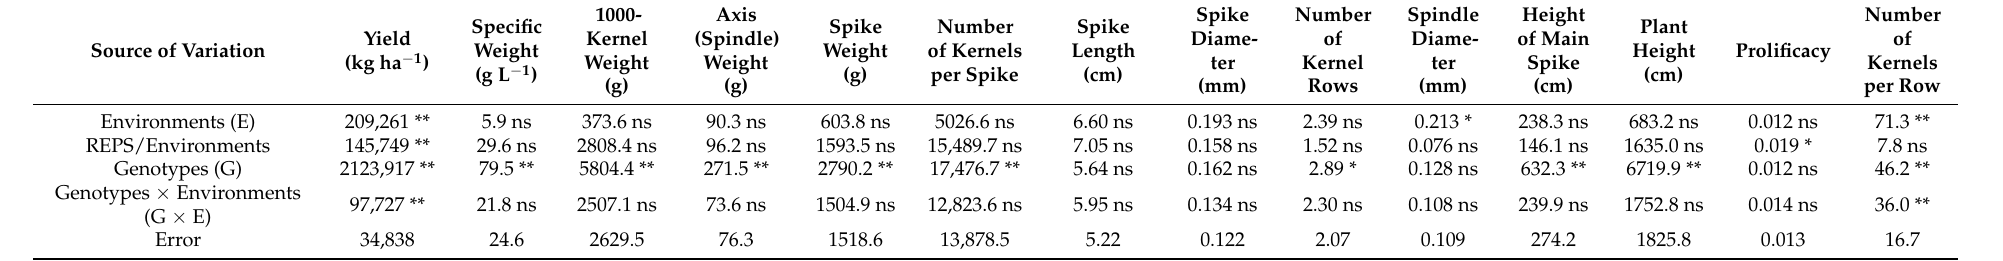
Table 1. Mean squares (m.s.) from analysis of variance over environments for tested traits: yield (kg ha − 1 ), specific weight (g L − 1 ), 1000-kernel weight (g), axis (spindle) weight (g), spike weight (g), number of kernels per spike, spike length (cm) and diameter (mm), number of kernel rows, spindle diameter (mm), main spike and plant height (cm), prolificacy, and number of kernels per row.